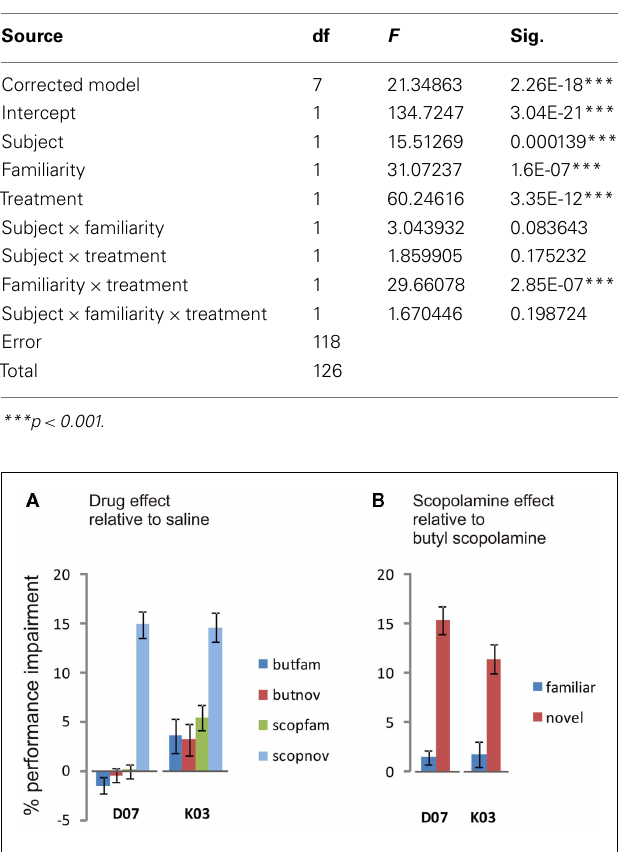
FIGURE 5 | Mean percent impairment of performance for each monkey for the categorization of familiar or novel stimuli compared to control. The means of the three highest coherence levels have been used in making these comparisons.The colors of the bars match the colors of the curves in Figure 4 , other than that the control in this case is not saline but butyl-scopolamine. (A) Mean percent performance change (Mean ± SE) of